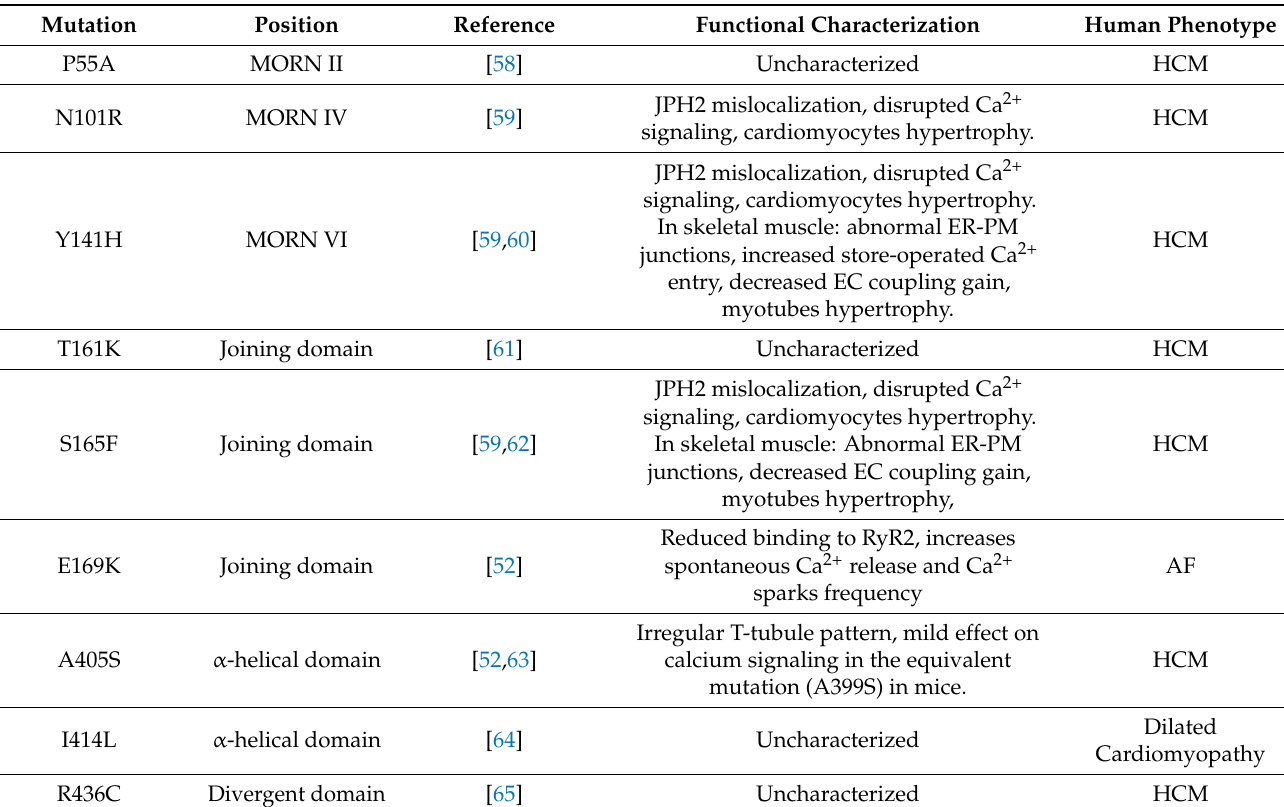
Table 1. Identified mutations in JPH2 linked to hypertrophic cardiomyopathy (HCM) and atrial fibrillation